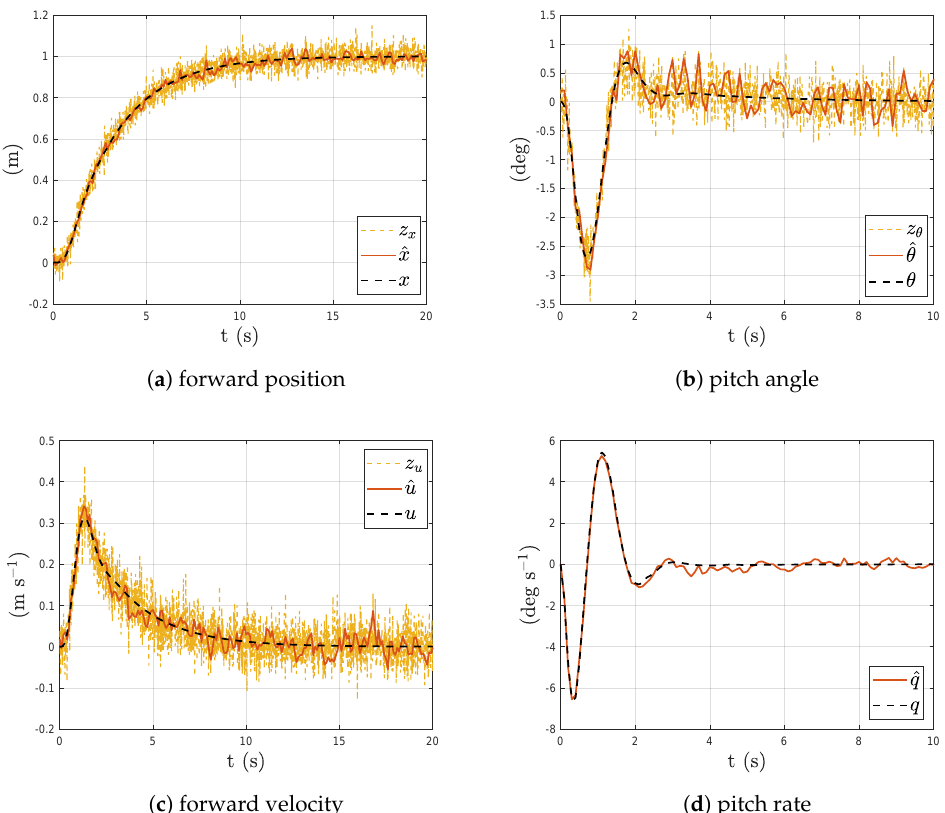
Figure 8. KF estimates (KF not in-the-loop) compared with measurements and true state during step response in position of non-linear aircraft